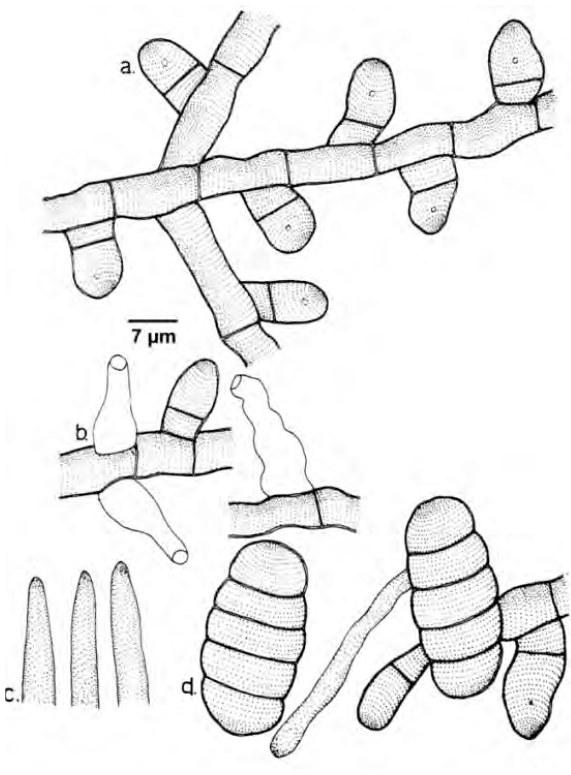
Figure 90. Meliola litsea var. keralensis a - Appressorium; b - Phialide; c - Apical portion of mycelial setae; d -